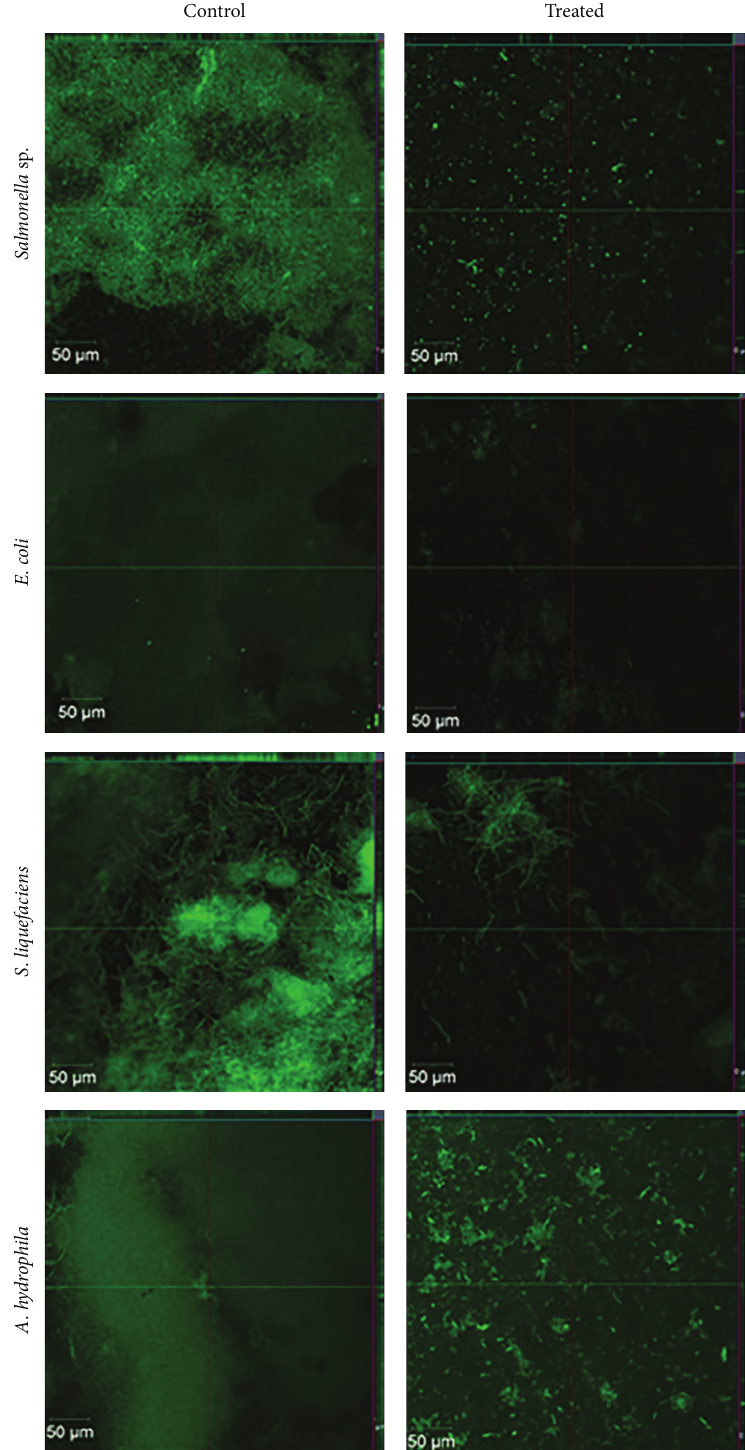
Figure 6: CLSM images representing the antibiofilm activity of Ag NPs against marine biofilm forming isolates of Salmonella sp., E. coli , S. liquefaciens , and A. hydrophila